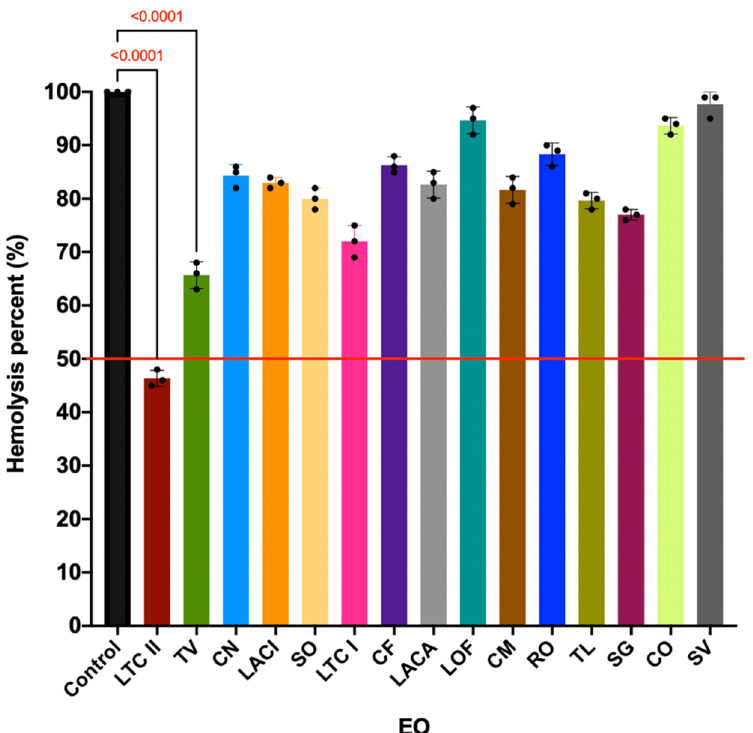
Figure 4. Effect of EOs at subinhibitory concentrations on the hemolytic activity of S. aureus ATCC 25922 after 16 h culture in LB medium at 37 °C. Inhibition percentage was calculated considering the hemolytic activity of the control culture (without EO treatment). All experiments were performed in triplicate and analyzed by ANOVA ( p > 0.05). The ordinary statistical one-way ANOVA analysis between LTC II and TV vs. control showed a p value ≤ 0.0001).